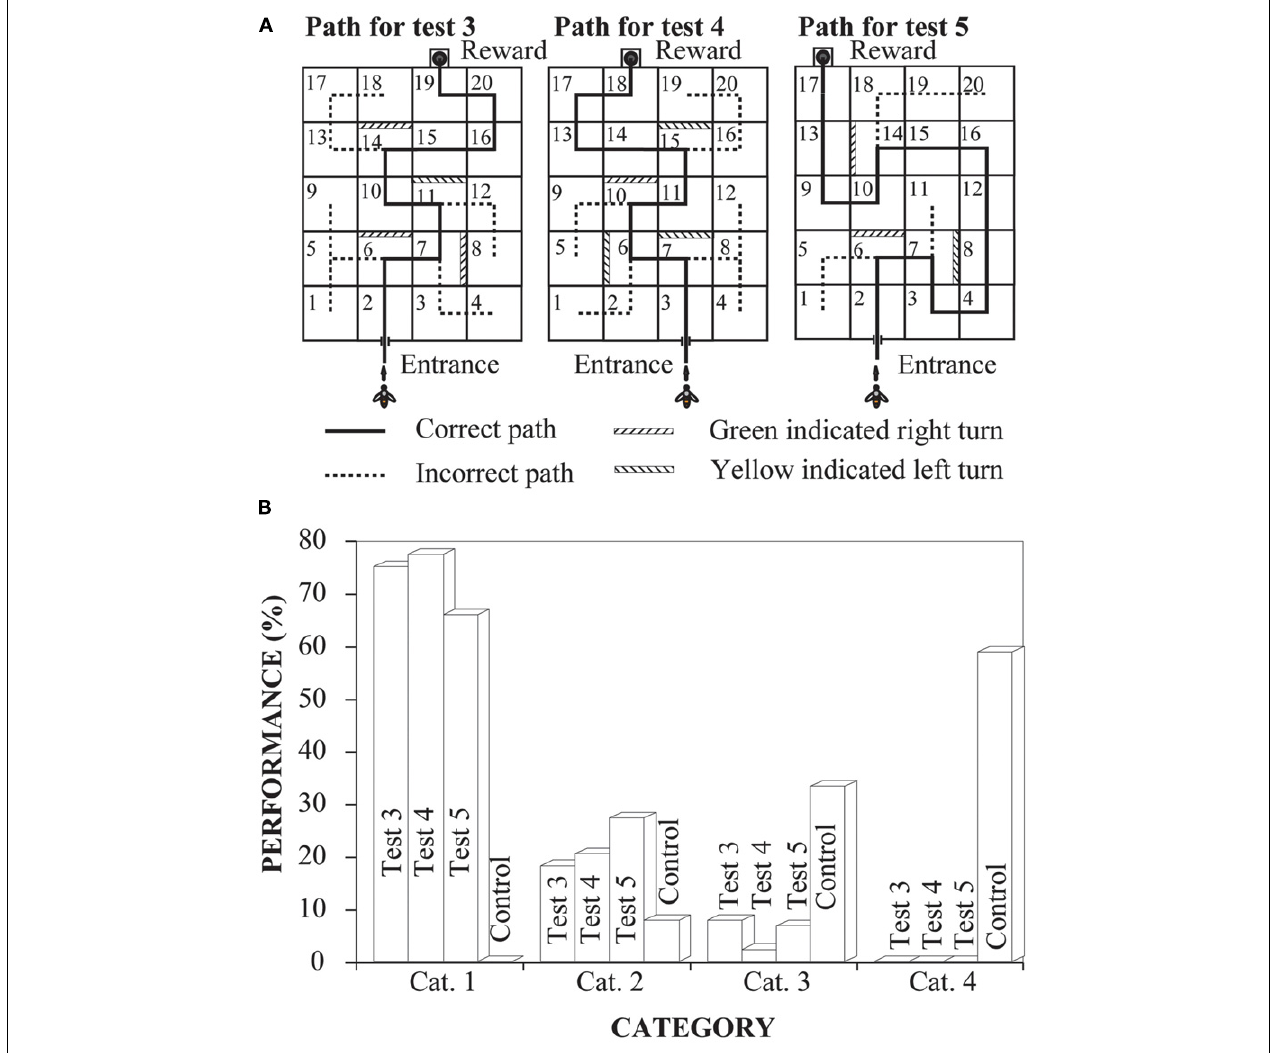
FIGURE 4 | Learning to negotiate mazes by following marks. (A) The experimental setups, indicating the correct path through the maze. (B) Experimental results. Performance was scored by assigning each flight into one of four categories as in Figure 3 . Modified from Zhang et al. (1996). Details in